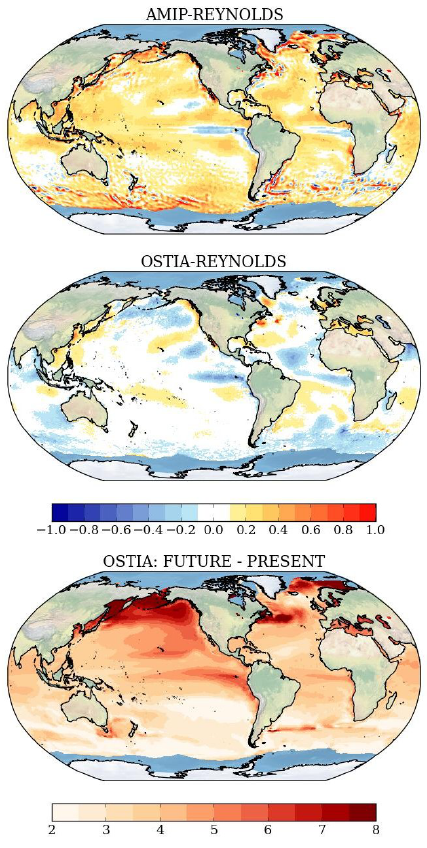
Figure 1. Spatial difference between 1986–2008 JJA mean SST in AMIP-II and Reynolds data sets (top) and OSTIA and Reynolds Fig. 1. Spatial difference between 1986-2008 JJA mean SST in AMIP-II and Reynolds datasets (top) and (middle). The bottom panel shows the future climate SST change OSTIA and Reynolds (middle). The bottom panel shows the future climate SST change applied, averaged over applied, averaged over JJA. The colour bars are annotated in Kelvin. JJA. The colour bars are annotated in Kelvin.